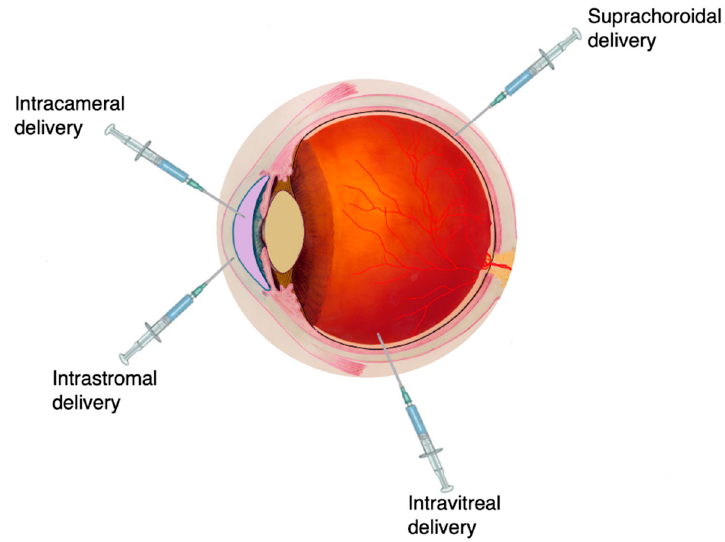
Figure 4. Common techniques to inject medicines to the eye. Administration via intravitreal injection is the most frequently used strategy, especially for targeting the back of the eye, such as the vitreous. Image adapted from National Eye Institute, National Institutes of Health. CC BY 4.0 license